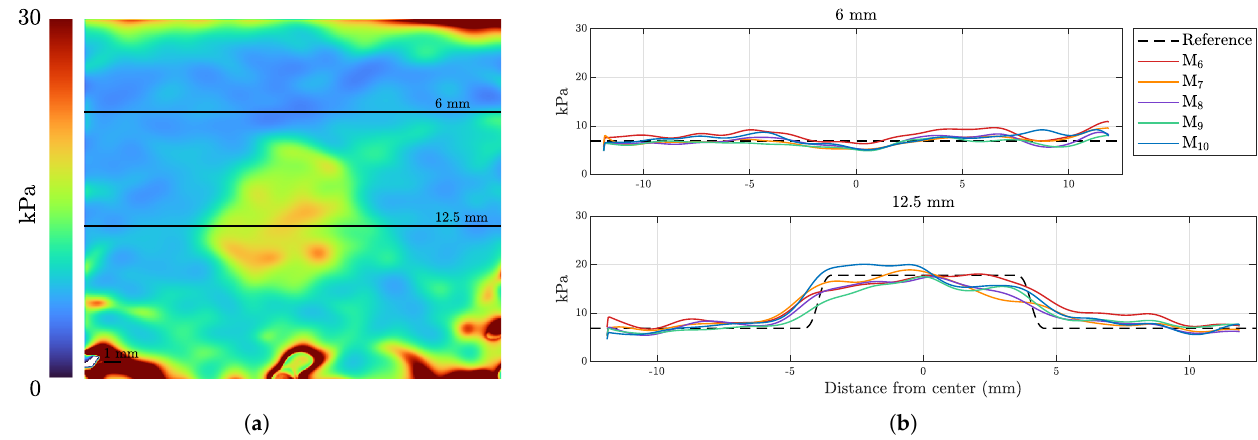
Figure 22. Comparison of the expected Young’s modulus at two defined depths in specimen I 4 . ( a ) The shown observation depths are measured from the transducer–tissue interface; ( b ) The elastography measurement data are displayed as solid lines and the mechanically measured reference as a dashed